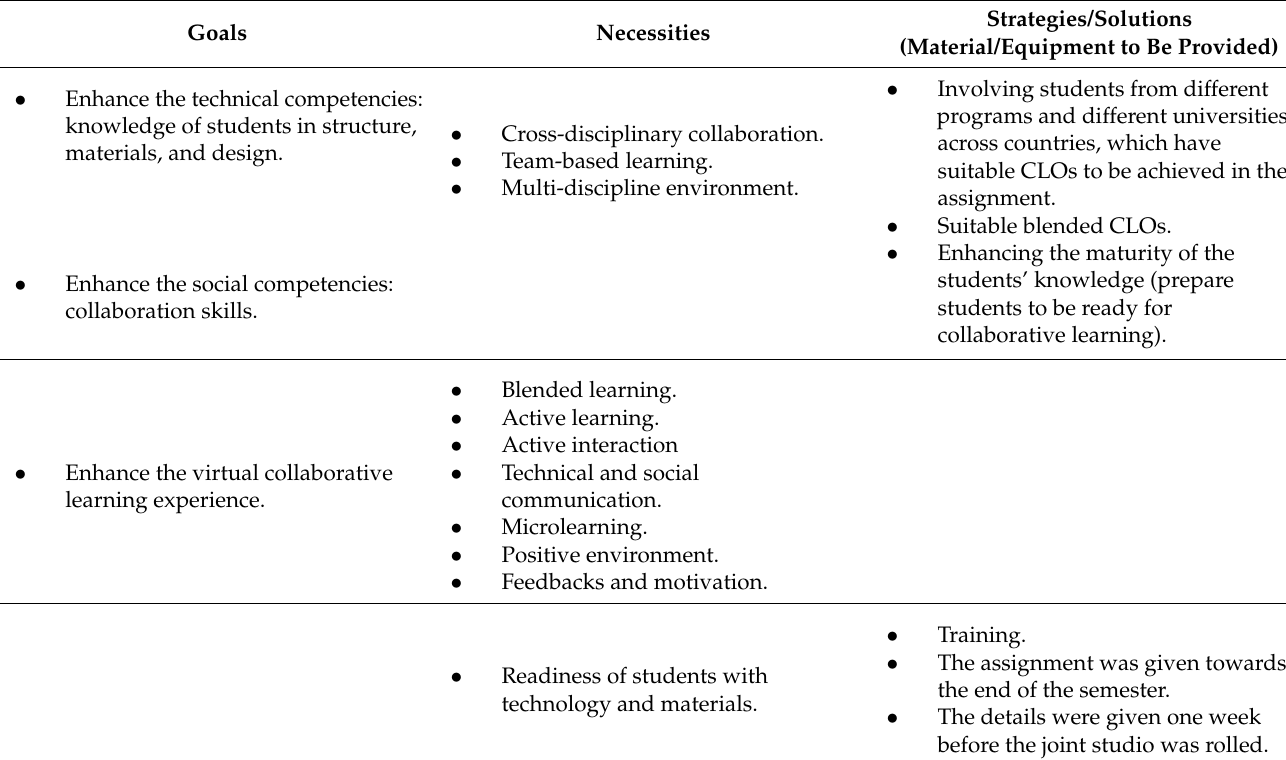
Table 4. Strategies for the implementation of joint studio assignment. Goals Necessities